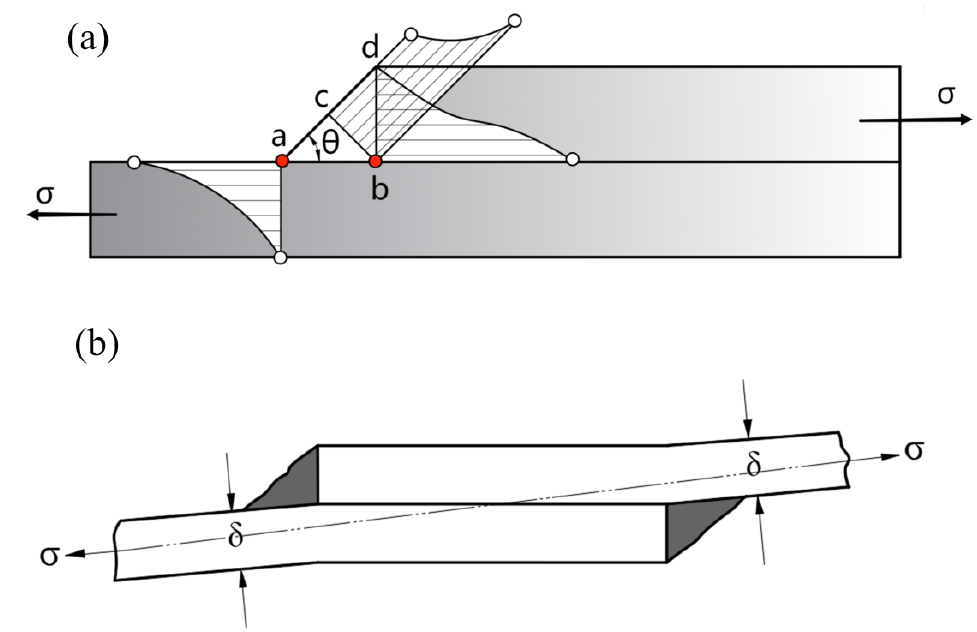
Figure 9. Stress distribution of 6005 lap welded joint during loading: ( a ) stress distribution field, ( b ) bending morphology at point a stress concentration.